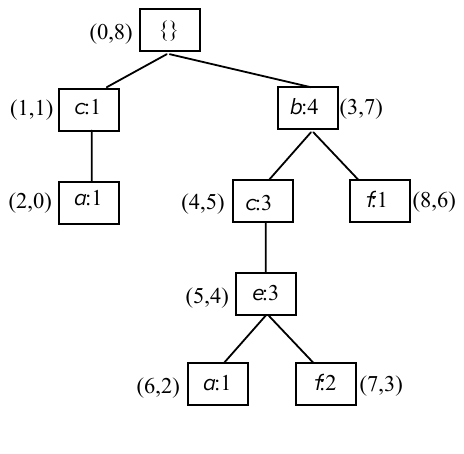
Fig. 1. The PPC-tree in Example